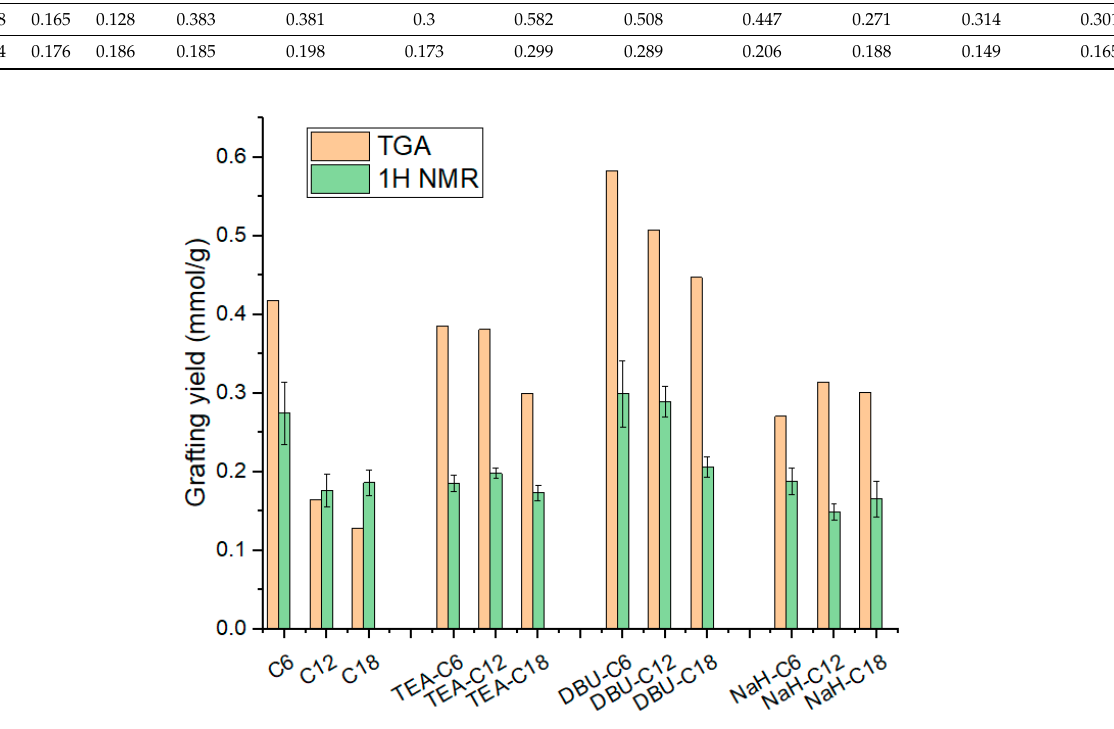
Figure 6. Silica silanization grafting yield from TGA and 1 H NMR.